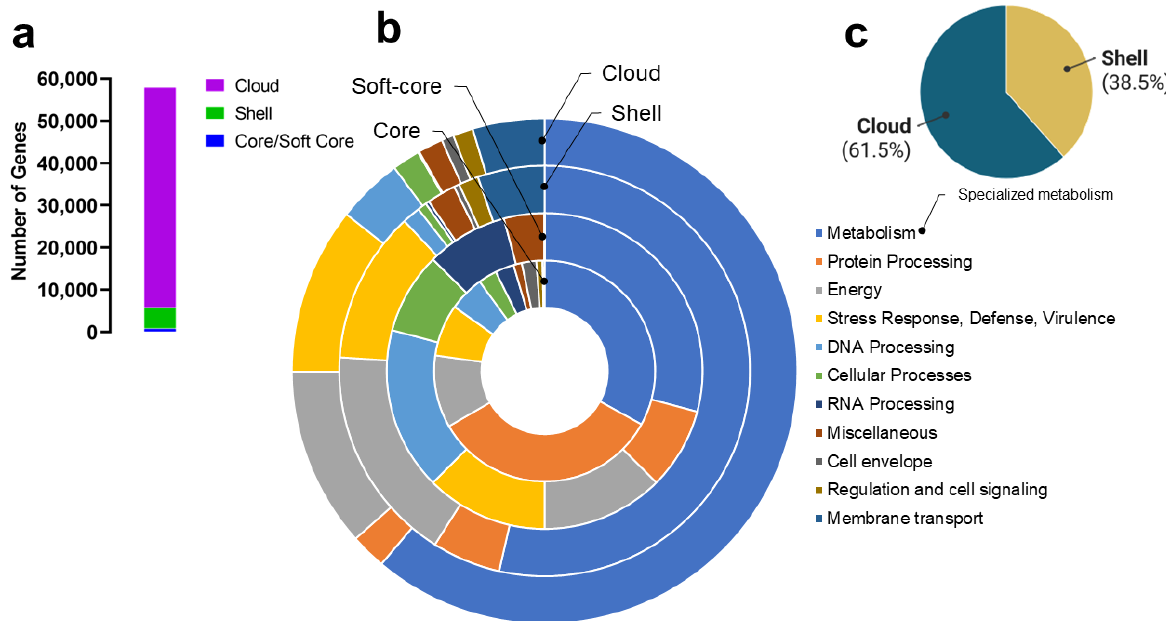
Figure 7. Overview of the assignments to functional subsystems of the Gordonia pan-genome. ( a ) Distribution of genes in core/softcore, shell, and cloud genomes. ( b ) Doughnut plot of the functional assignment of genes in the core, softcore, shell, and cloud genome (from the inner to the outer ring, respectively). ( c ) Pie chart of the distribution of genes assigned to specialized metabolism in core and shell genomes (no genes were found within core and softcore genomes).